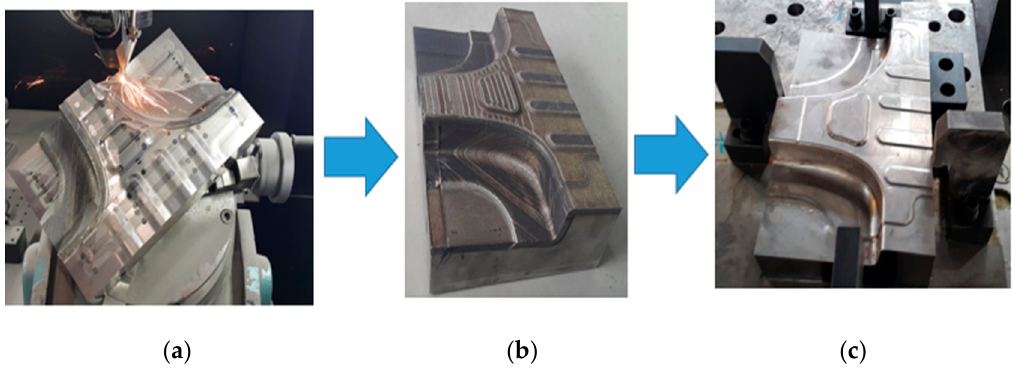
Figure 14. Fabrication of a cooling block with a conformal cooling channel using heterogeneous material AM technology: ( a ) cooling block body coupon assembly, ( b ) cooling block after AM processing ( c ) cooling block after machining the AM cooling block surface.